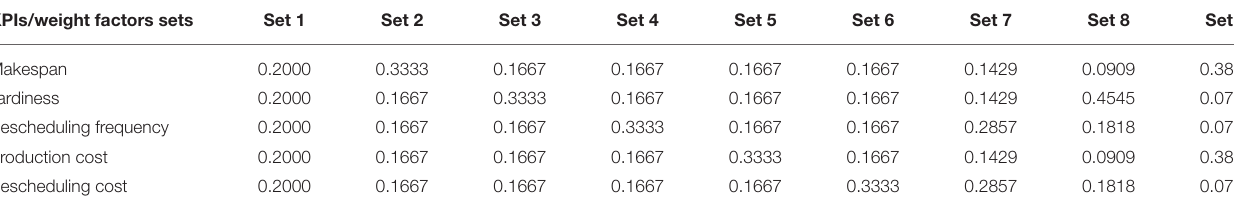
TABLE 4 | Weight factor sets.